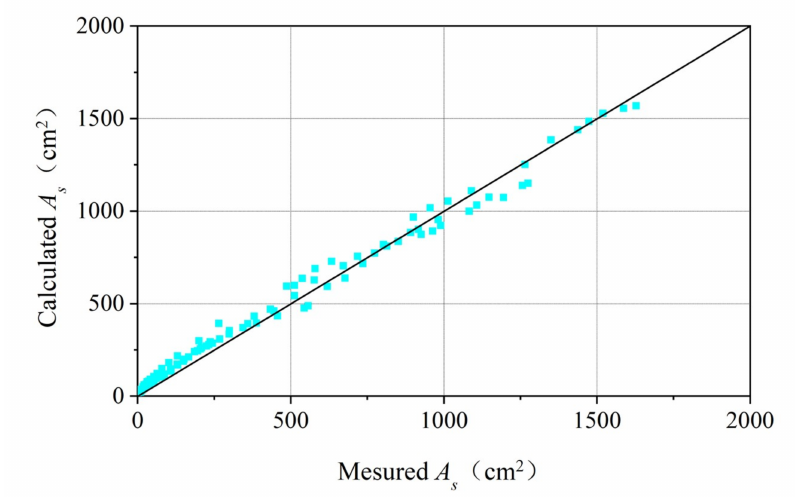
Figure 7. Comparison of measured and calculated averaged longitudinal scour